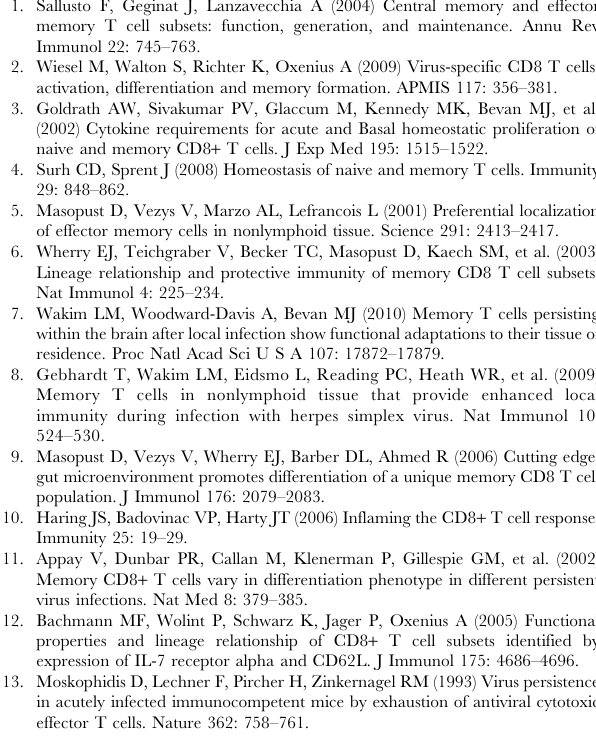
Figure S4 Bcl-2 expression kinetics in M38- and M45- specifc CD8 T cells. (A)10 5 Mini CD8 T cells were transferred in WT R WT and WT R H-2 Kb 2 / 2 chimeric mice one day prior to infection with MCMV- D m157. Blood samples were collected on days 7, 9, 11, 13, 17, 21, 27, 42 and 60 post infection. Graphs show the Bcl-2 expression kinetics of M38- (triangles) and M45- specific (circles) CD8 T cells in WT R WT (left graph) and WT R H-2 Kb 2 / 2 (right graph) mice. One of two independent experiments is shown. (B) In a separate experiment, Bcl-2 expression was analyzed for M38- and M45-specific CD8 T cells in the lungs of mice which had been infected with MCMV- D m157 for 7, 14, 28 and 150 days. One of two independent experiments is